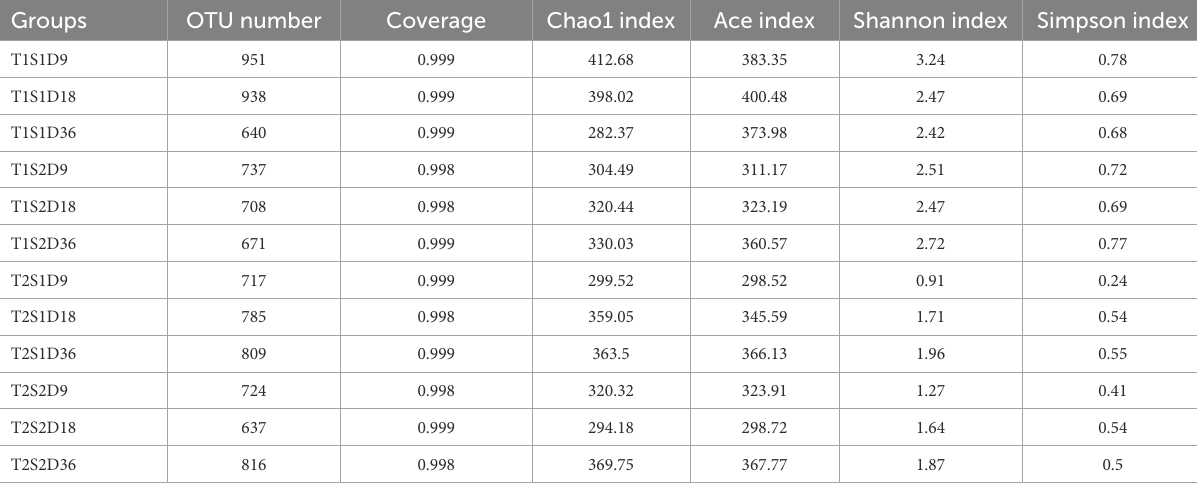
TABLE 1 Alpha diversity of bacterial communities around leaves.